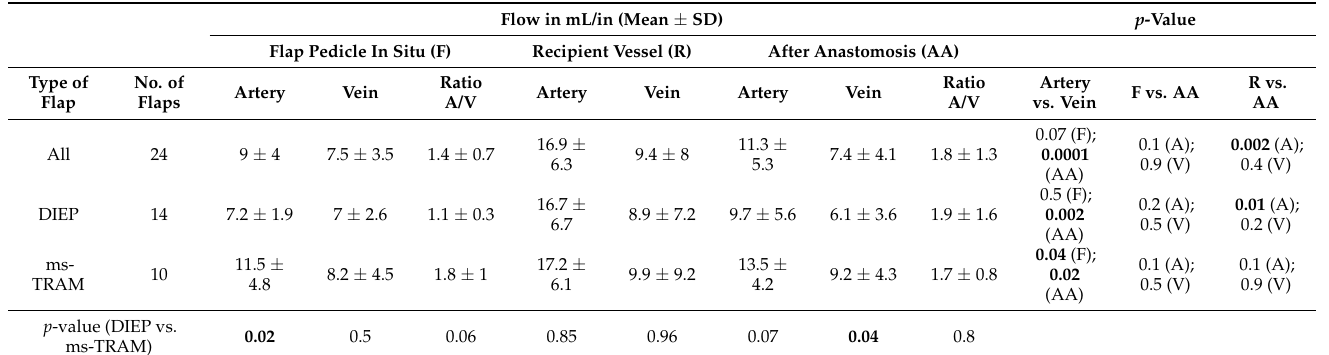
Table 2. Comparison of the Blood flow (mL/min) of the Flap Pedicle in situ (F), of the Recipient Artery (R), and After Anastomosis (AA).